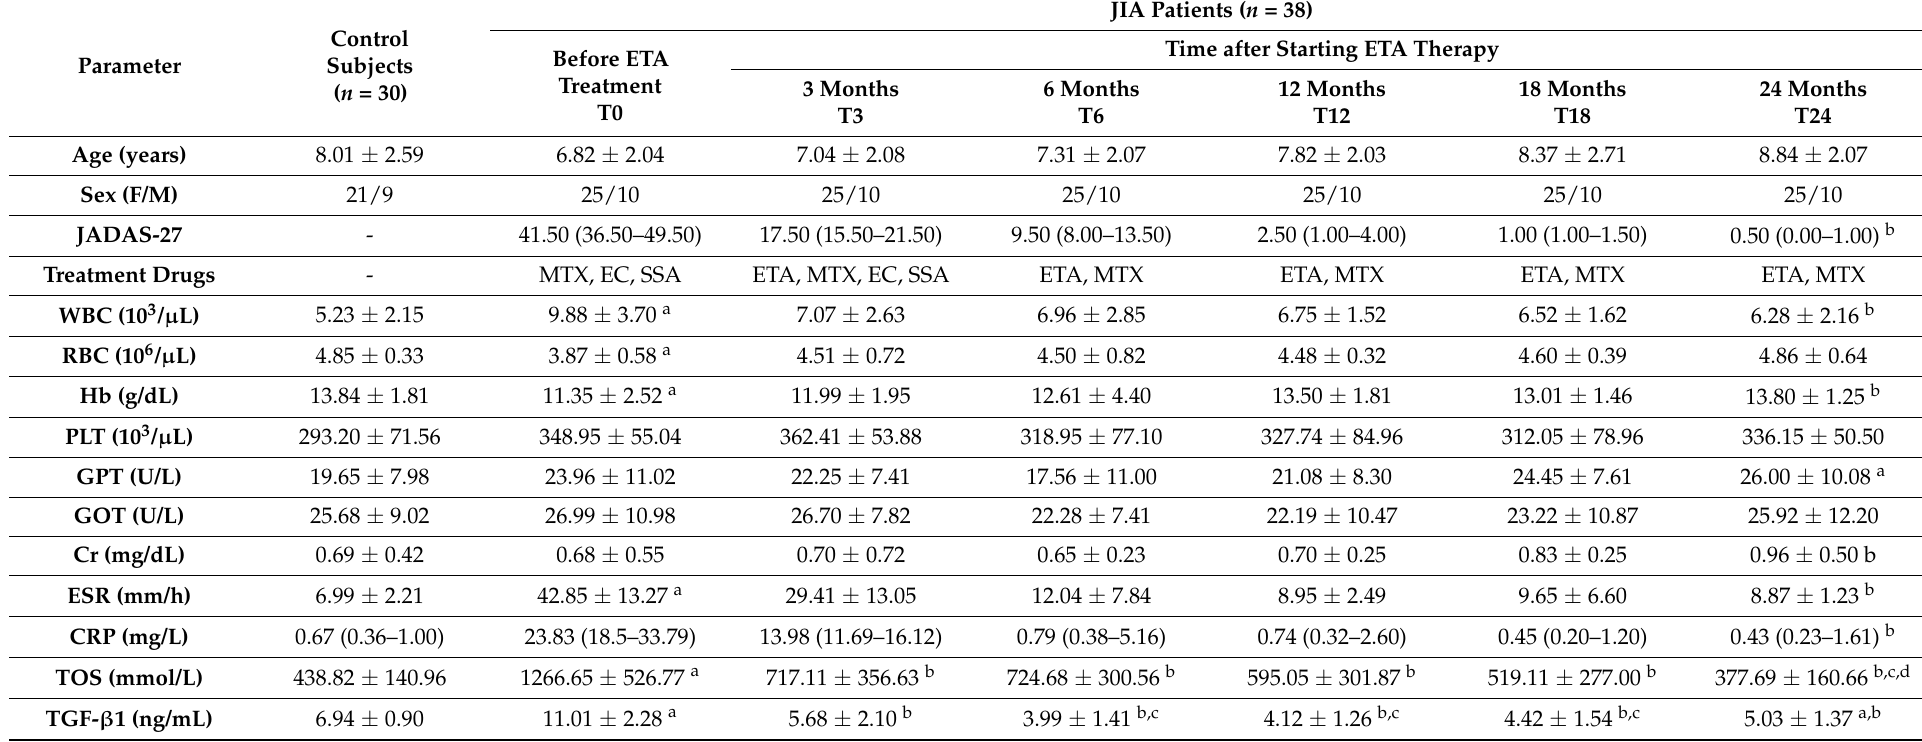
Table 1. The clinical data of control subjects and JIA